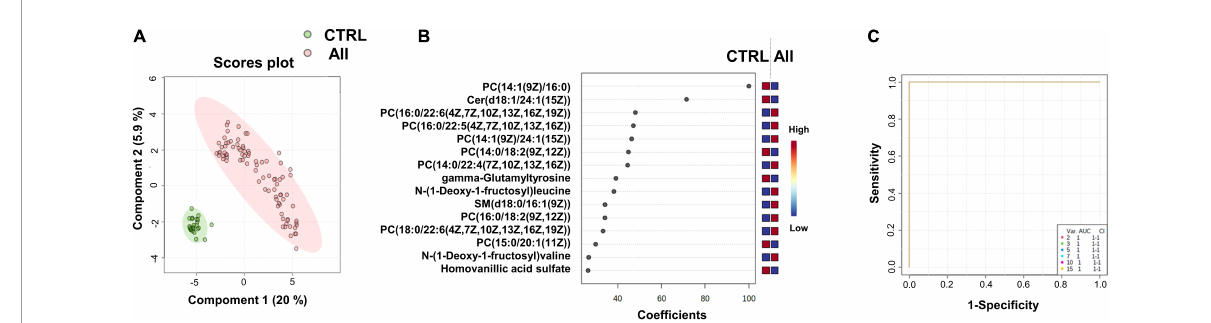
FIGURE1 Identification of putative biomarkers of SARS-CoV-2 infection. PLS-DA analyses based on untargeted plasma metabolomic profiling discriminated healthy control subjects (CTRL) from all SARS-CoV-2 infected subjects (All, including mild, moderate and severe cases). Green and red dots represent CTRL and SARS-CoV-2 infected subjects, respectively. The score plot is represented with a confidence ellipse of 95% (A) . Loading plots of the top 15 features (metabolites) selected on the average of the first five components of the PLS-DA model. Identified metabolites were validated by MS2 analyses and are shown as chemical names (B) . Pairwise comparisons of areas under multivariate ROC curves (AUC) from each prognosis predictor (C) .